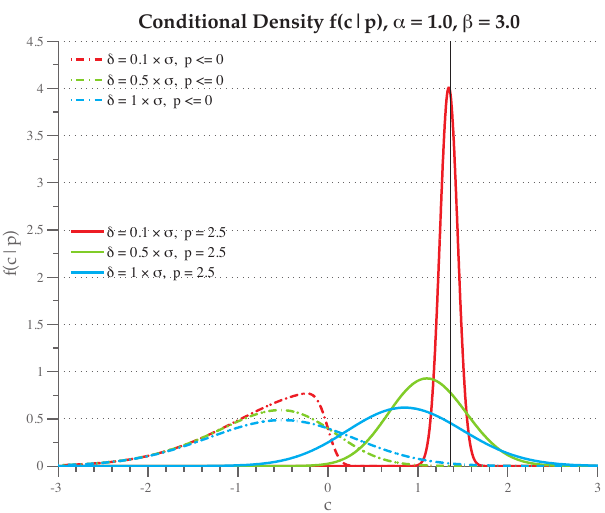
Figure A1. Posterior probability density functions of climate, ac- cording to Eqs. (6, 7), with µ = 0, σ = 1, α = 1, and β = 3 and the noise level δ taking on the values [ 0 . 1 , 0 . 5 , 1 ]× σ . Solid and dashed lines lines correspond, respectively, to proxy values of p = 2 . 5 and p = 0. The black vertical line marks the point ( p/α ) value of c in the absence of